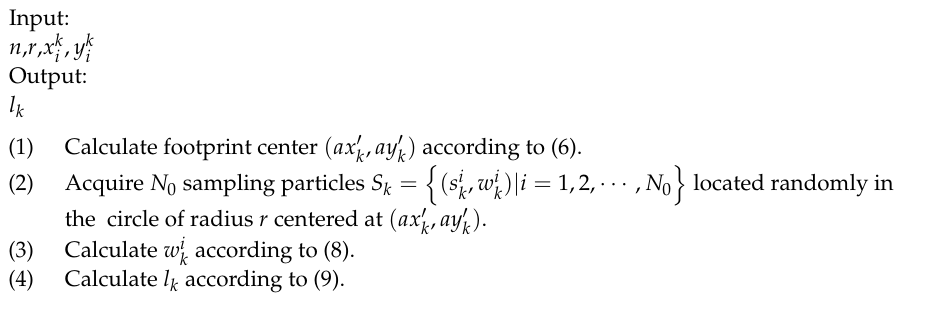
Algorithm 1 Monte Carlo positioning